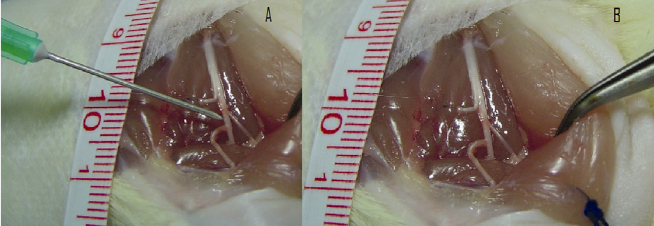
FIGURE 3 - Trans-operatory picture of a Group C animal. A) Fibrin glue application. B) Aspect of end-to-side nerve anastomosis after application fibrin glue